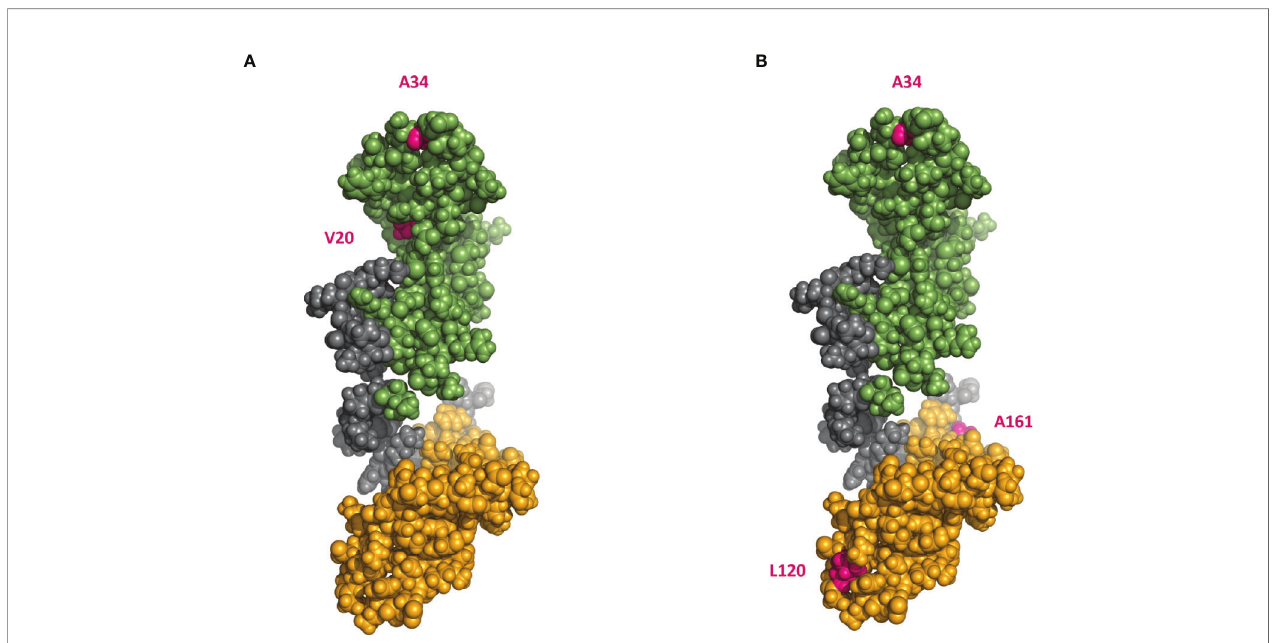
FIGURE 7 | A 3D model indicating proposed cleavage sites at HMGB1 by HNE and MMP3. (A) 3D model of HMGB1 showing predicted HNE cleavage sites at positions V20 and A34 (B) 3D model of HMGB1 showing predicted MMP3 cleavage sites at positions A34, L120 and A161 (pink). Box A is marked in green, box B marked in yellow. The model is based on solution structure of the tandem HMG box domain from Human High mobility group protein B1 aa 1 – 166, #2YRQ in the RCSB Protein Data